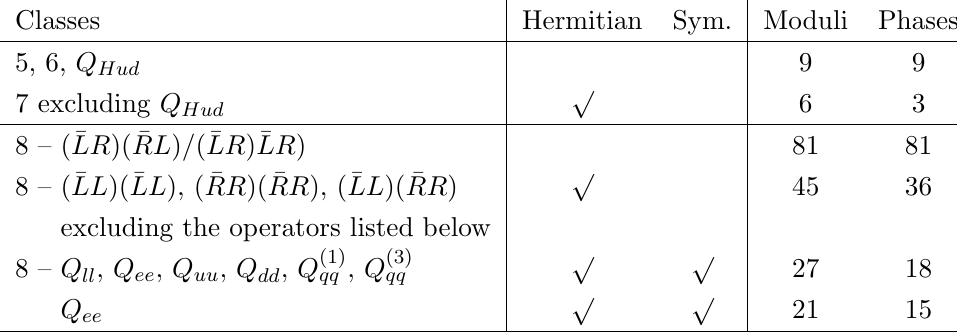
Table 4 . The number of independent parameters per Wilson coe(cid:14)cient for fermionic operators. The operators constructed out of 2 fermions and 4 fermions are divided into the upper and lower